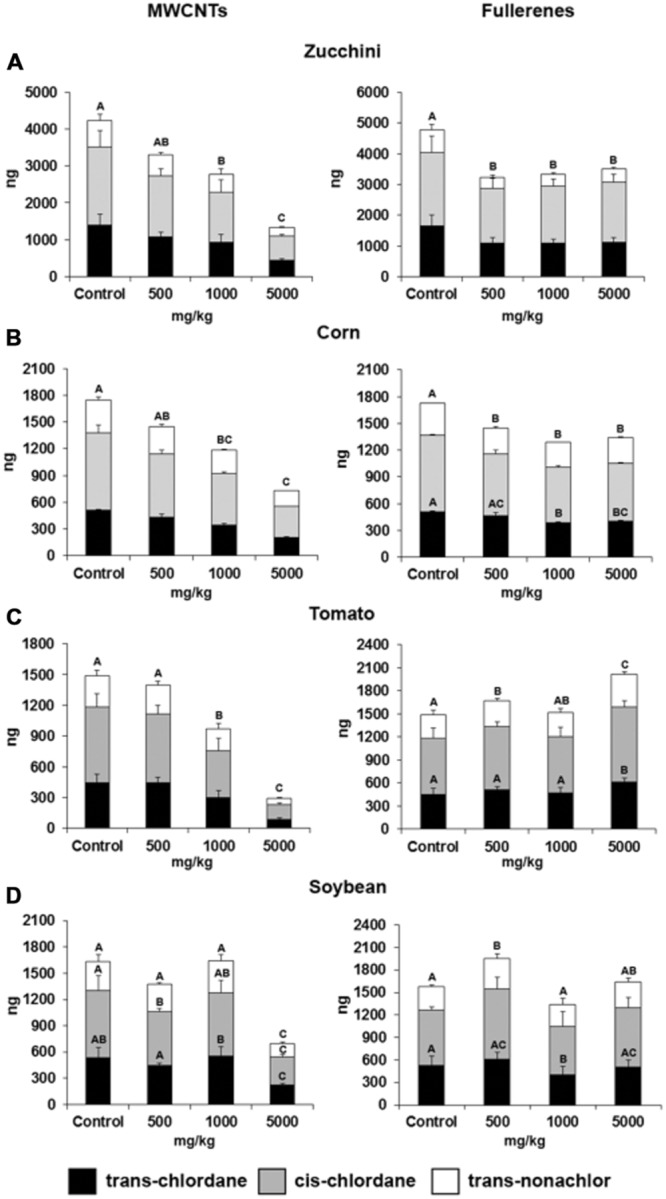
Total plant content of chlordane components in soil-grown (A) zucchini, (B) corn, (C) tomato, and (D) soybean co-exposed to 0–5000 mg/kg MWCNT or C60 fullerene. Error bars are the standard error. Within a plant species and nanomaterial type, chlordane components with different letters are significant different. If no letter is shown, differences are not significant. Reprinted with permission from De La Torre-Roche et al. (2013), Copyright © 2013 American Chemical Society.